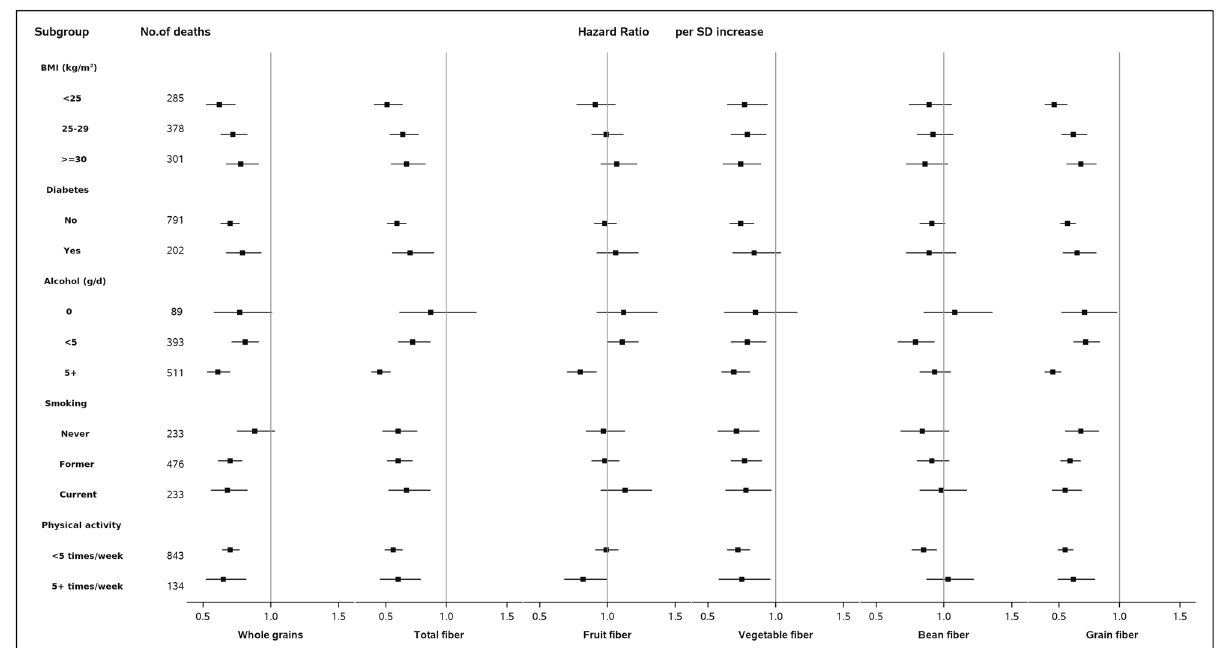
Fig. 2 Strati fi ed analyses for association between whole grain and dietary fi ber intake with CLD mortality among the participants of NIH – AARP Diet and Health Study. Cox proportional hazard regression models were used. All P -values were two-sided. Models were strati fi ed by sex and adjusted for age at baseline (continuous), level of education ( ‘ ≤ 11 years ’ , ‘ high school ’ , ‘ vocational technology school ’ , ‘ some college ’ , ‘ college/postgraduate ’ ), race ( ‘ non- hispanic white ’ , ‘ non-hispanic black ’ , ‘ hispanic ’ , ‘ asian, Paci fi c Islander, or American Indian/Alaskan native ’ ), BMI ( ‘ < 25 ’ , ‘ 25 – 30 ’ , ‘ 30 + ’ , kg/m 2 ), alcohol use ( ‘ non-drinker ’ , ‘ 0.1 – 4.9 ’ , ‘ 5 – 9.9 ’ , ‘ 10 + ’ , gram/day), tobacco smoking ( ‘ never smoked ’ , ‘ former smoker ’ , ‘ current smoker ’ ), physical activity ( ‘ never ’ , ‘ rarely ’ , ‘ 1 – 3 time per month ’ , ‘ 1 – 2 times per week ’ , ‘ 3 – 4 times per week ’ , ‘ 5 + times per week ’ ), history of diabetes ( ‘ no ’ , ‘ yes ’ ) and total energy intake (continuous), except when the variable is used for strati fi cation. The P for interaction between whole grain or fi ber intake and characteristics for strati fi cation in CLD mortality were as follows: Whole grain: 0.01 for BMI, 0.07 for diabetes, <0.01 for alcohol use, <0.01 for smoking, and 0.73 for physical activity. Total fi ber: 0.03 for BMI, 0.05 for diabetes, <0.01 for alcohol use, 0.96 for smoking, and 0.52 for physical activity. Fiber from fruits: <0.01 for BMI, 0.10 for diabetes, <0.01 for alcohol use, 0.97 for smoking, and 0.16 for physical activity. Fiber from vegetables: 0.83 for BMI, 0.11 for diabetes, 0.72 for alcohol use, 0.63 for smoking, and 0.76 for physical activity. Fiber from beans: 0.87 for BMI, 0.84 for diabetes, 0.23 for alcohol use, 0.07 for smoking, and 0.07 for physical activity. Fiber from grains: <0.01 for BMI, 0.13 for diabetes, <0.01 for alcohol use, 0.15 for smoking, and 0.40 for physical